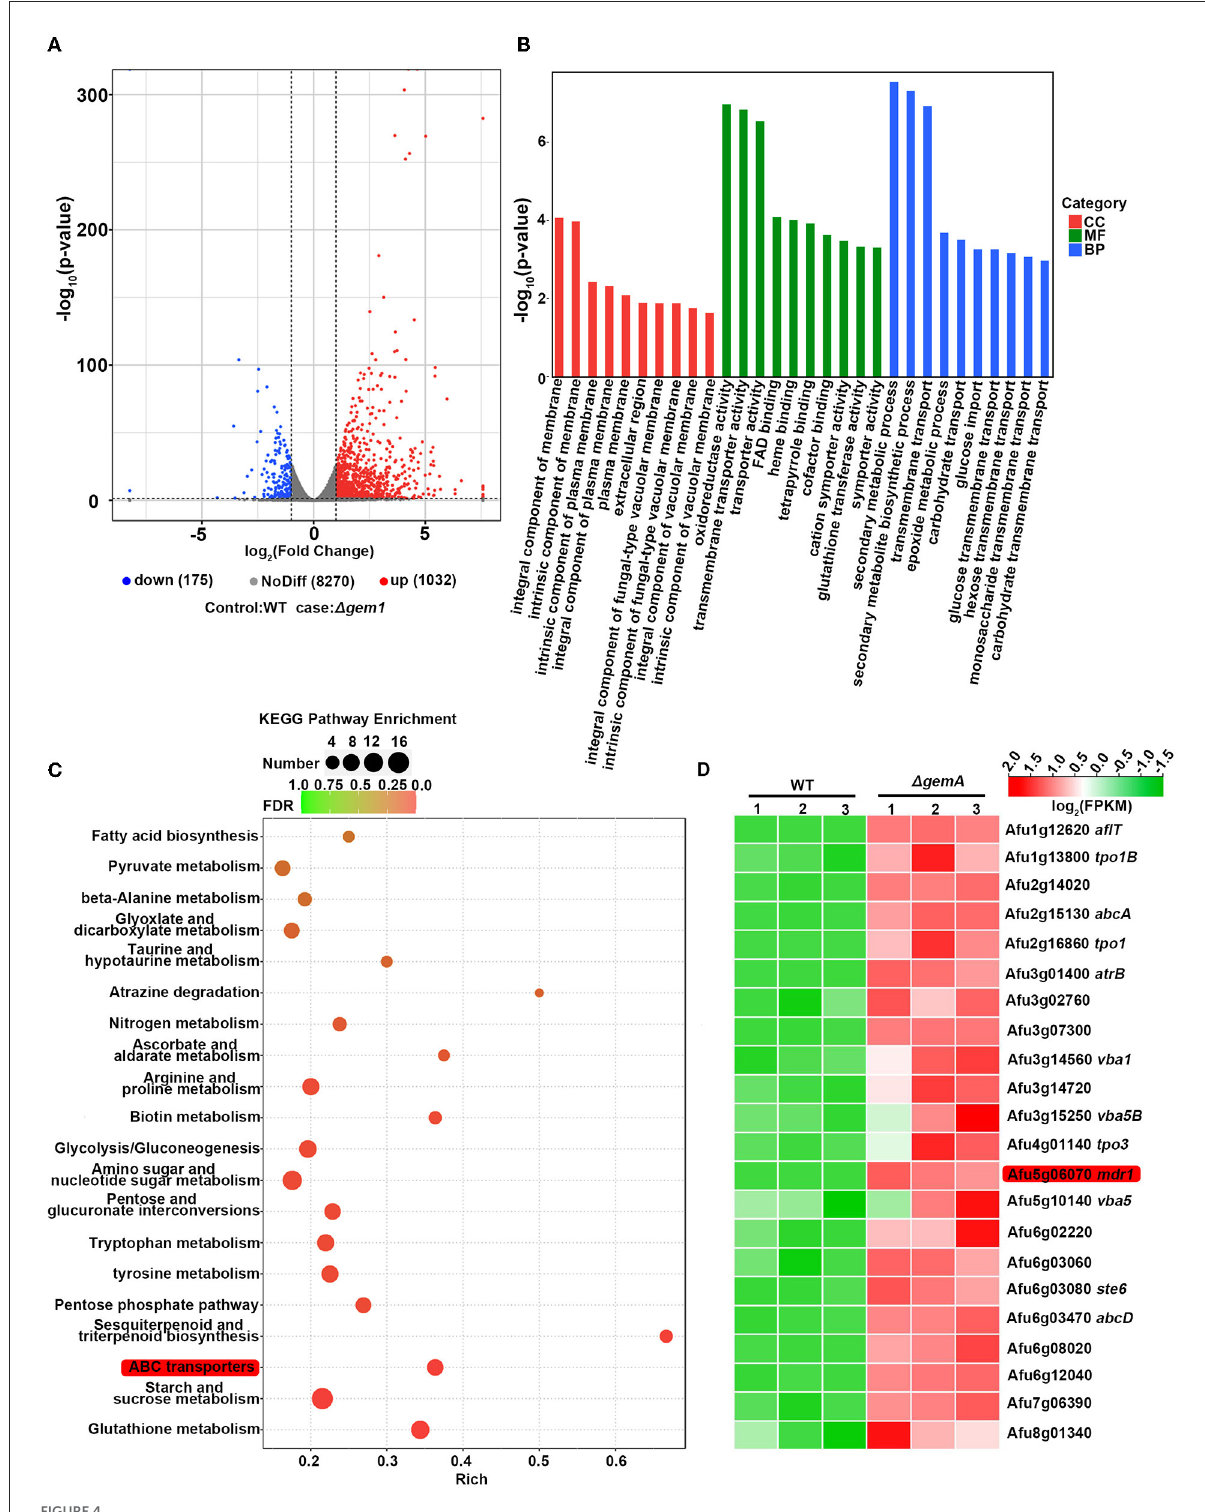
FIGURE4 RNA-seq data analysis in the gemA mutant and its parental WT strain. (A) The volcano plot showed the differentially expressed genes in the gemA mutant compared with the WT strain. (B) Functional category and (C) signal pathway enrichment analyses were performed using GO and KEGG databases. (D) A heatmap comparison of drug efflux pump-related genes between the gemA mutant and its parental WT strain by using RNA-seq